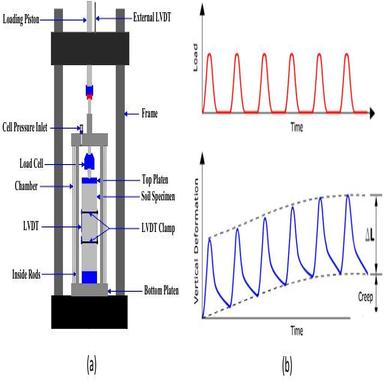
RLTT Characteristics a) Schematic Diagram of The Triaxial Testing Apparatus , b) Generated Irrecoverable Creep Under Repeated-Loading Sequences .